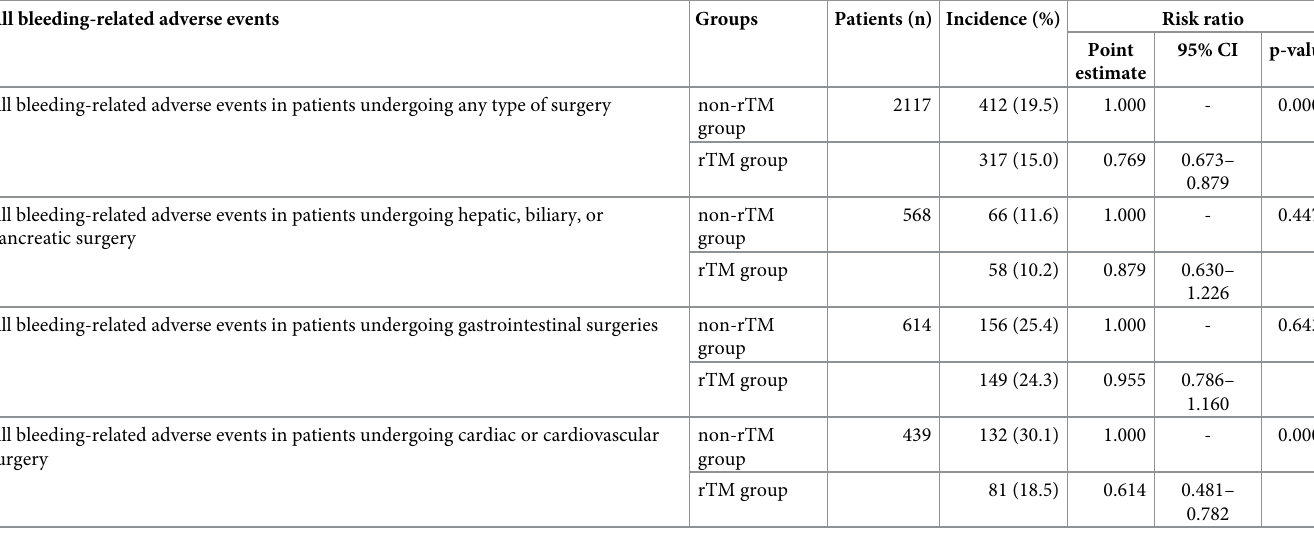
Table 3. Summary of bleeding-related adverse events with an incidence > 1% in all patients and in those undergoing any type of surgery, hepatic, biliary, or pancre- atic surgery; gastrointestinal surgeries; and cardiac or cardiovascular surgery requiring blood transfusion or a hemostatic procedure after the day of DIC treatment. All bleeding-related adverse